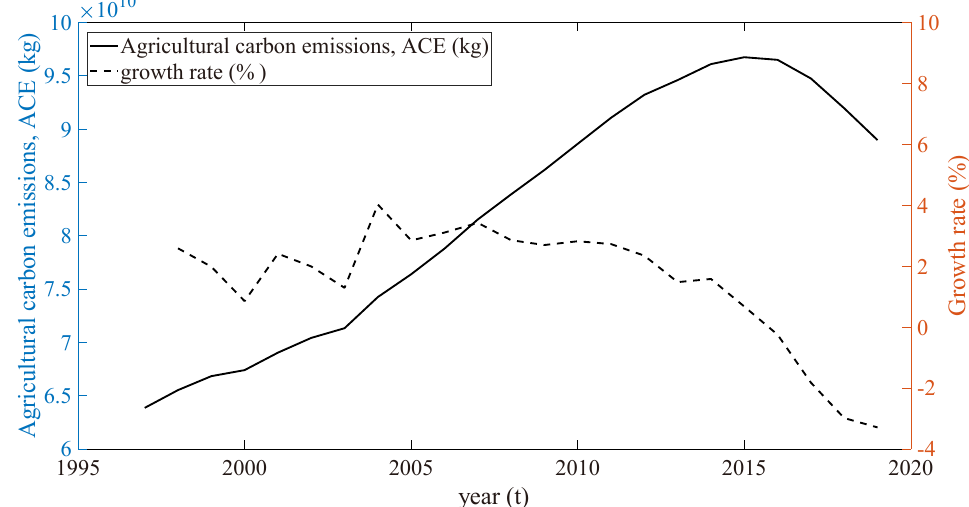
Figure 2. China’s agricultural carbon emission (ACE, kg) and its growth rate